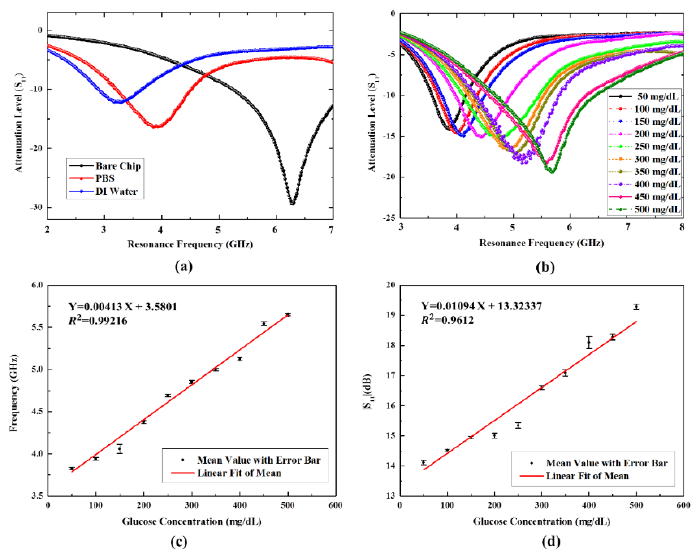
Figure 5. Shift in resonance frequency and magnitude of reflection coefficient (S 11 ) under different conditions: ( a ) various solution and ( b ) various glucose samples concentrations (50–500 mg/dL). Regression analysis for the shift in resonance frequency ( c ) and magnitude of reflection coefficient (S 11 ) ( d ) with error bars for different glucose sample concentrations.